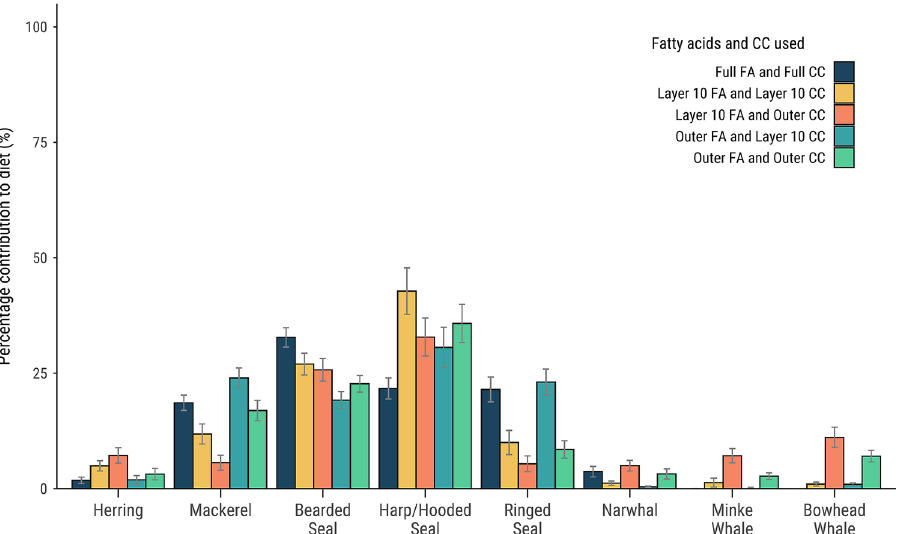
Figure 5. Diet estimates for Greenlandic killer whales (n = 16) for full blubber FA signatures and full blubber CCs, and four combinations of outer blubber and layer 10 (the outermost layer) FA signatures and CCs. The simulated diets resulted in a similar percentage of prey species, with the four main species being harp and hooded seal, mackerel, bearded seal, and ringed